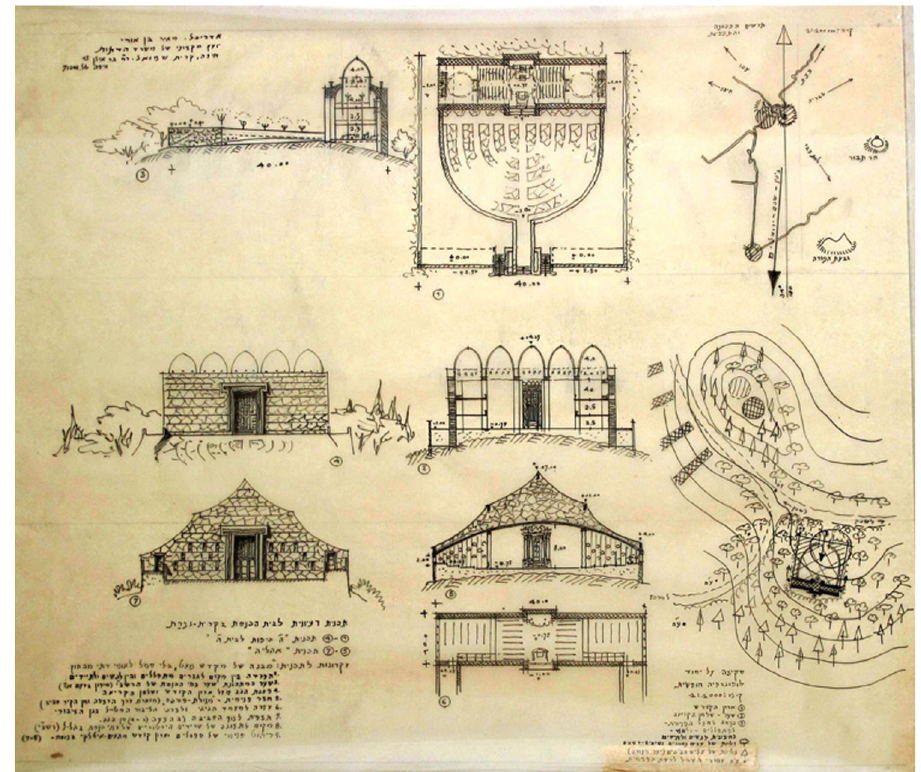
Fig. 2 The Central Synagogue of Nazareth Illit, Architect Meir Ben-Uri ’ s design proposal, 1957 (Meir Ben Uri ’ s Archive, Haifa. Kiryat Nazareth synagogue, fi le no. 320.00-0. Courtesy of Meir Ben Uri ’ s